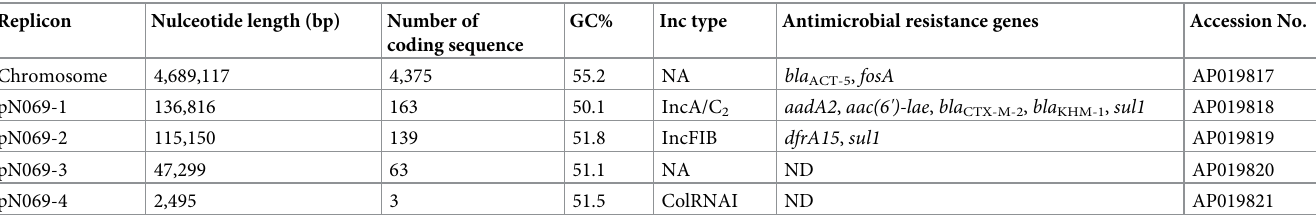
Table 2. Whole genome information for E . hormaechei subsp. hoffmannii isolate OIPH-N069.